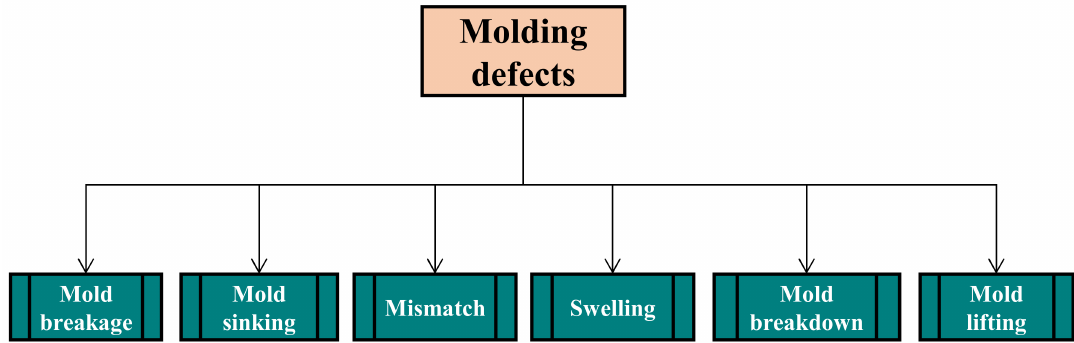
Figure 42. Classification of the different molding defects considered in this